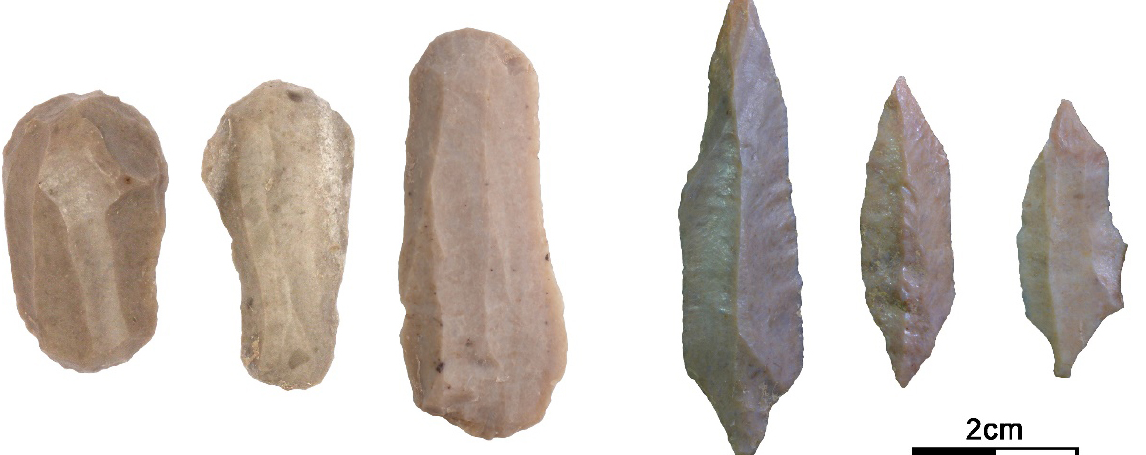
Figure 4. End scrapers and arrowheads (Nemrik type) made of heat-treated